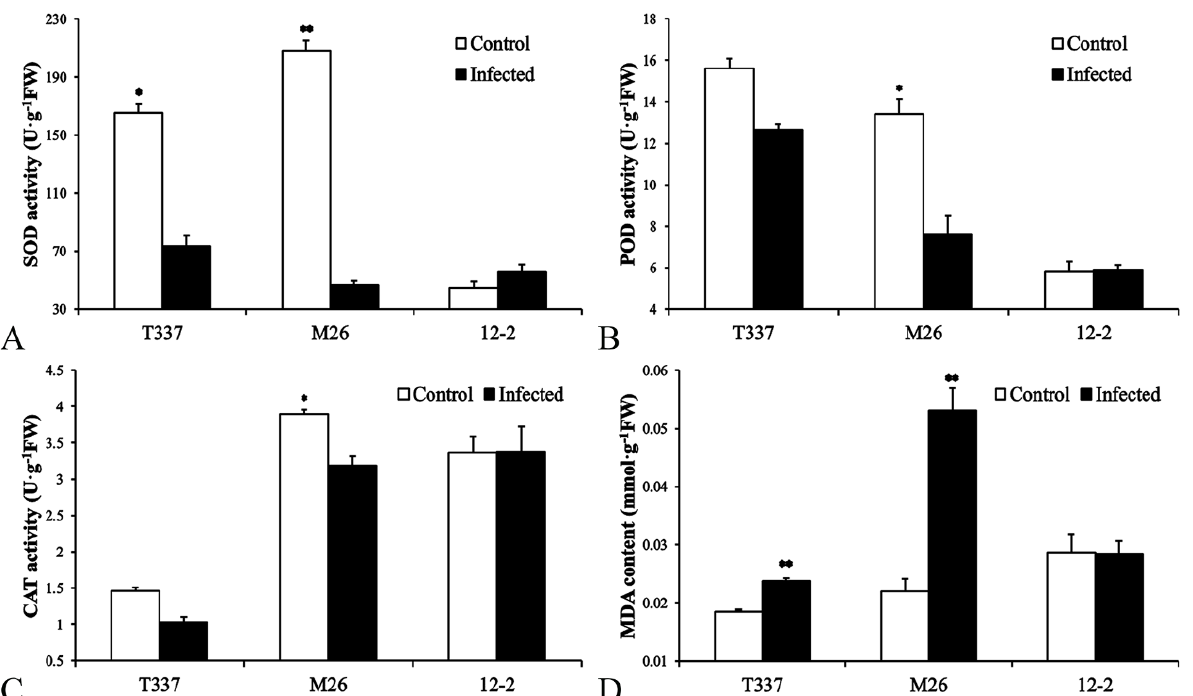
Figure 6. Effects of F. proliferatum MR5 on leaf antioxidant-enzyme activities and malondialdehyde (MDA) content: ( A ) SOD activity; ( B ) POD activity; ( C ) CAT activity; ( D ) MDA content. The Stu- dent’s t -test was used to detect differences between the control and infected treatments within a rootstock. * p < 0.05; ** p < 0.01.